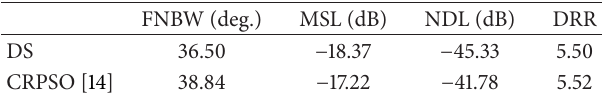
Table 1: FNBW, MSL, NDL, and DRR values obtained by DS and CRPSO [14] for the first example (12 elements).